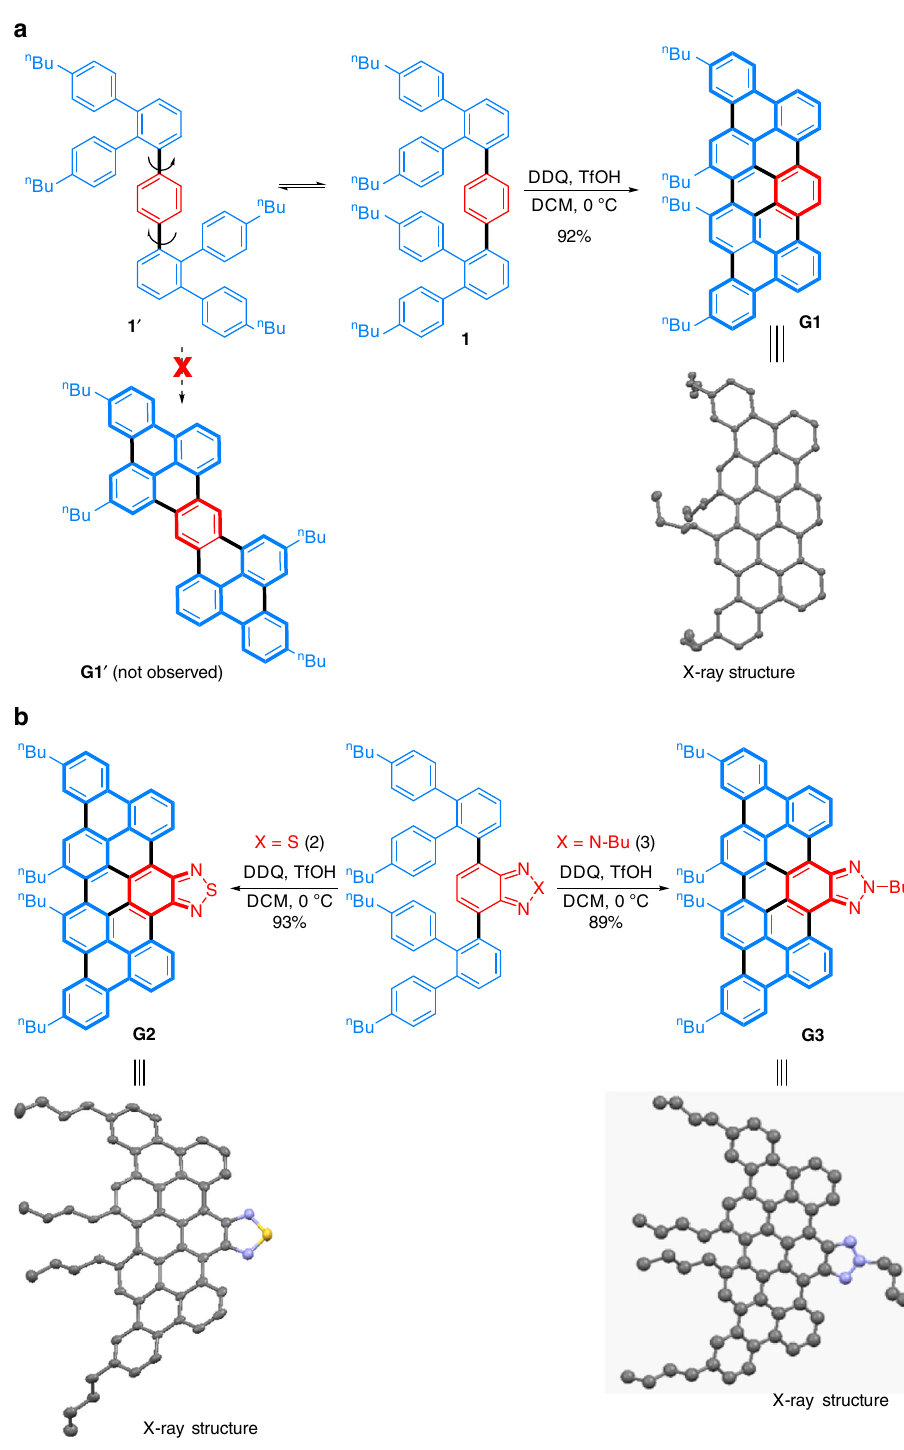
Fig. 2 Synthesis of model nanographenes. a Regioselective synthesis of pristine nanographene G1 as a model for N = 6 aGNRs. b Synthesis of edge- functionalized nanographenes ( G2 and G3 ). DDQ: 2,3-dichloro-5,6-dicyano-1,4-benzoquinone. TfOH: tri fl uoromethanesulfonic